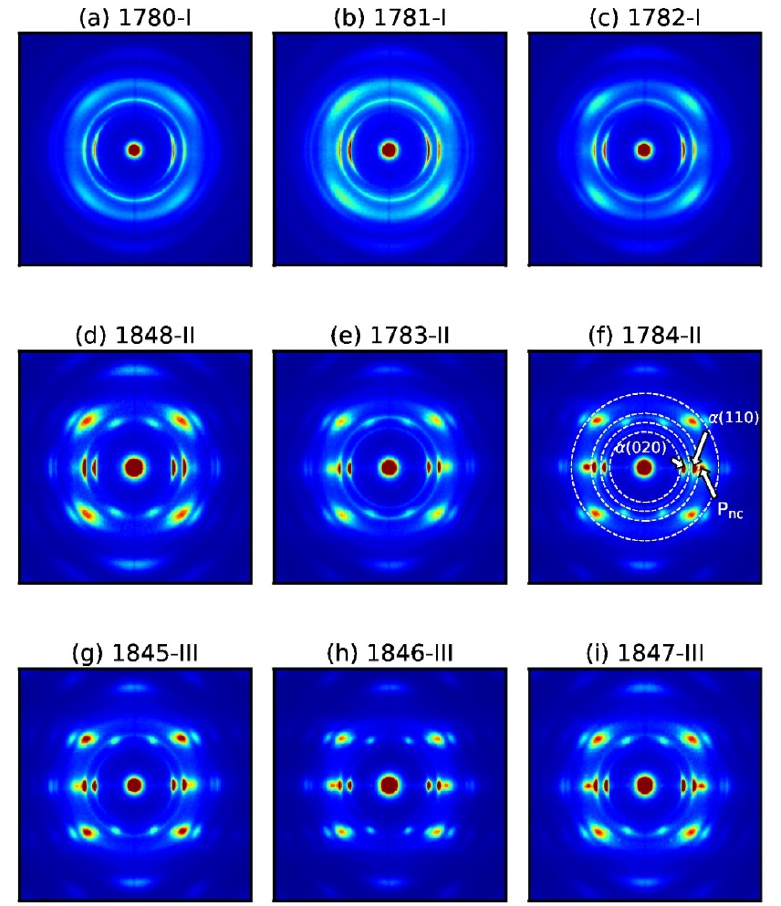
Figure 9. 2D WAXD patterns of melt-spun PHBH monofilaments for polymer grade I ( a – c ), II ( d – f ), III ( g – i ). The integrated azimuthal annuli are marked with dashed white lines in panel ( f ).